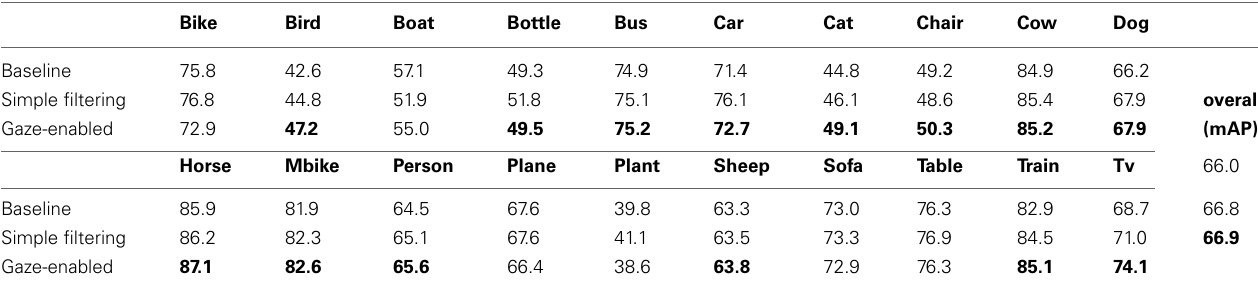
adding gaze would probably increase detection performance; for categories marked as ( − ) adding gaze would likely decrease performance.